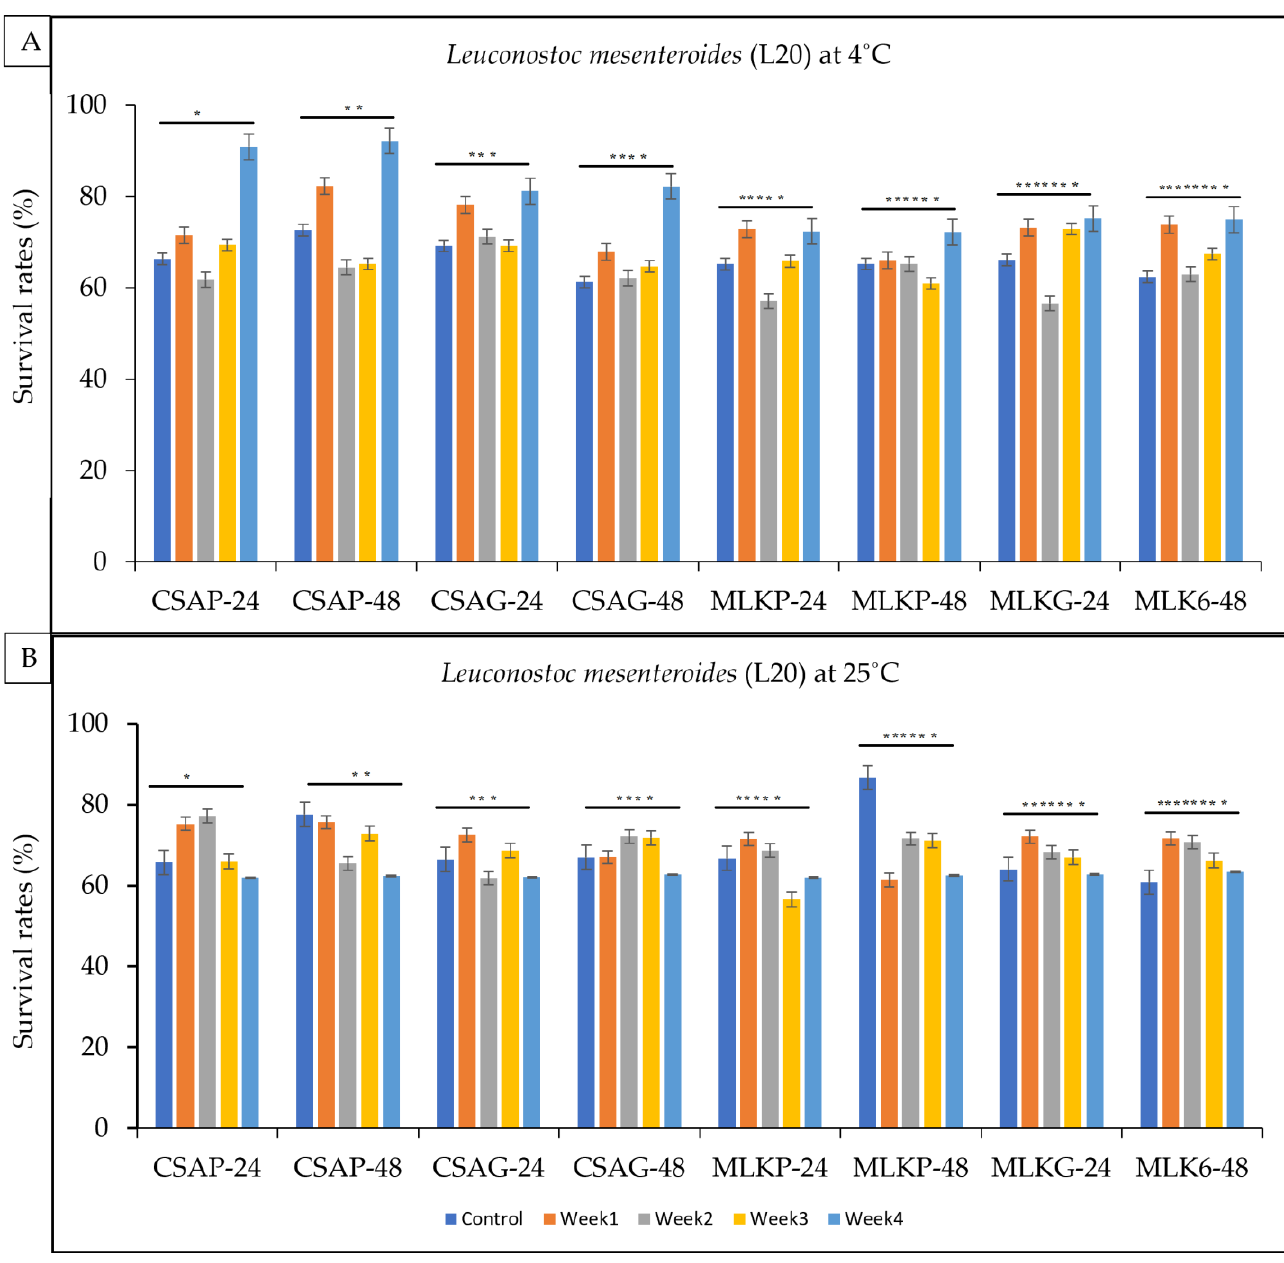
Figure 4. Viability of Leuconostoc mesenteroides (L20) following freeze-drying. ( A ) Survival rates at ambient temperature (25 °C), and ( B ) survival rates at refrigerated temperature (4 °C) for 24 h and 48 h. CSAP-24-Cassava in plastic at 24 h, CSAP-48-Cassava in plastic at 48 h, CSAG-24-Cassava in glass at 24 h, CSAG-48-Cassava in glass at 48 h, MLKp-24-Milk in plastic at 24 h, MLKP-48-Milk in plastic at 48 h, MLKG-24-Milk in glass at 24 h, MLKG-48-Milk in glass at 48 h. (Values represent means of three replicate experiments, ±: standard deviation). For ( A ) * p -value = 0.03162, ** p -value = 0.30846, *** p -value = 0.00104, **** p -value = 0.00153, ***** p -value = 0.35890, ****** p -value = 0.30947, ******* p -value = 0.16470, ******** p -value = 0.00014. For ( B ) * p -value = 0.00081, ** p -value = 0.00025, *** p -value = 0.36361, **** p -value = 0.16799, ***** p -value = 0.09687, ****** p -value = 0.0000001, ******* p -value = 0.00267, ******** p -value = 0.000004.